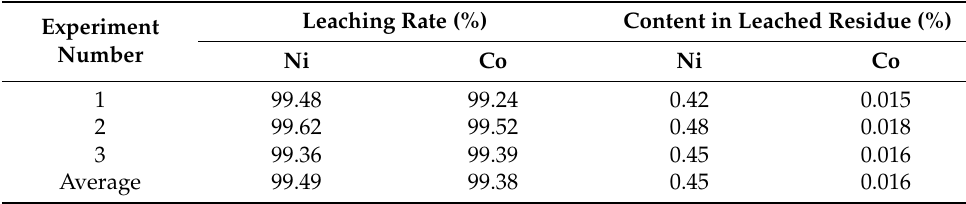
Table 2. Reproducibility of pressure leaching of an oxygen-rich NiS/CoS